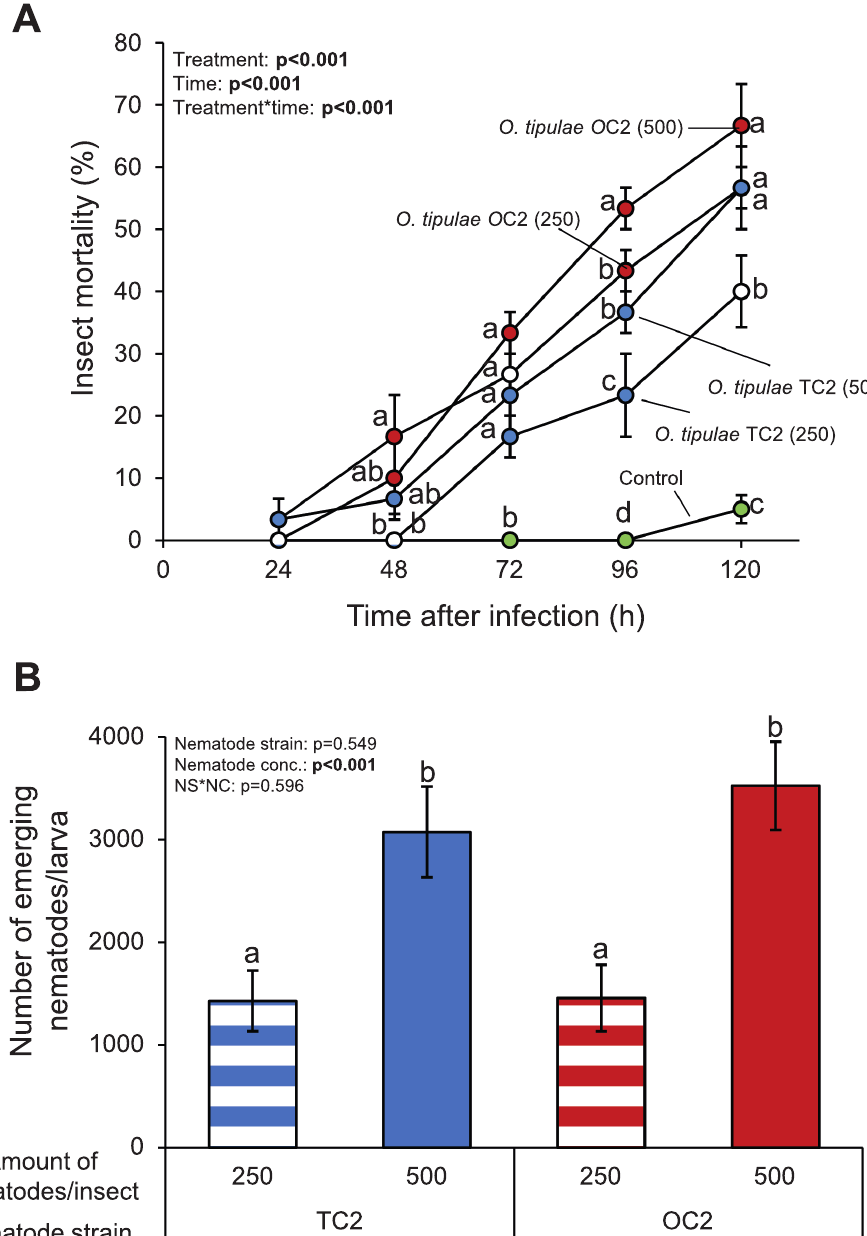
Fig 6. Lethality and reproductive potential of O . tipulae nematodes in G . mellonella larvae. (A) Mean ( ± S.E.M.) mortality of G . mellonella larvae at different time points after applying either 250 or 500 O . tipulae nematodes per larva. Three Petri plates with 10 larvae each per nematode concentration were assayed (n = 3). Controls consisted of water treated larvae. Six Petri plates with 10 larvae each were assayed (n = 6). Different letters indicate significant differences between treatments within time points (P < 0.05 by two-way repeated measures ANOVA with Holm’s multiple comparisons test). (B) Number of nematodes that emerge from G . mellonella larvae within ten days after nematode infestation. Infested insects were individually placed in White traps (n = 13–20 per treatment). Different letters indicate significant differences between treatments (P < 0.05 by two-way ANOVA with Holm’s multiple comparisons test).